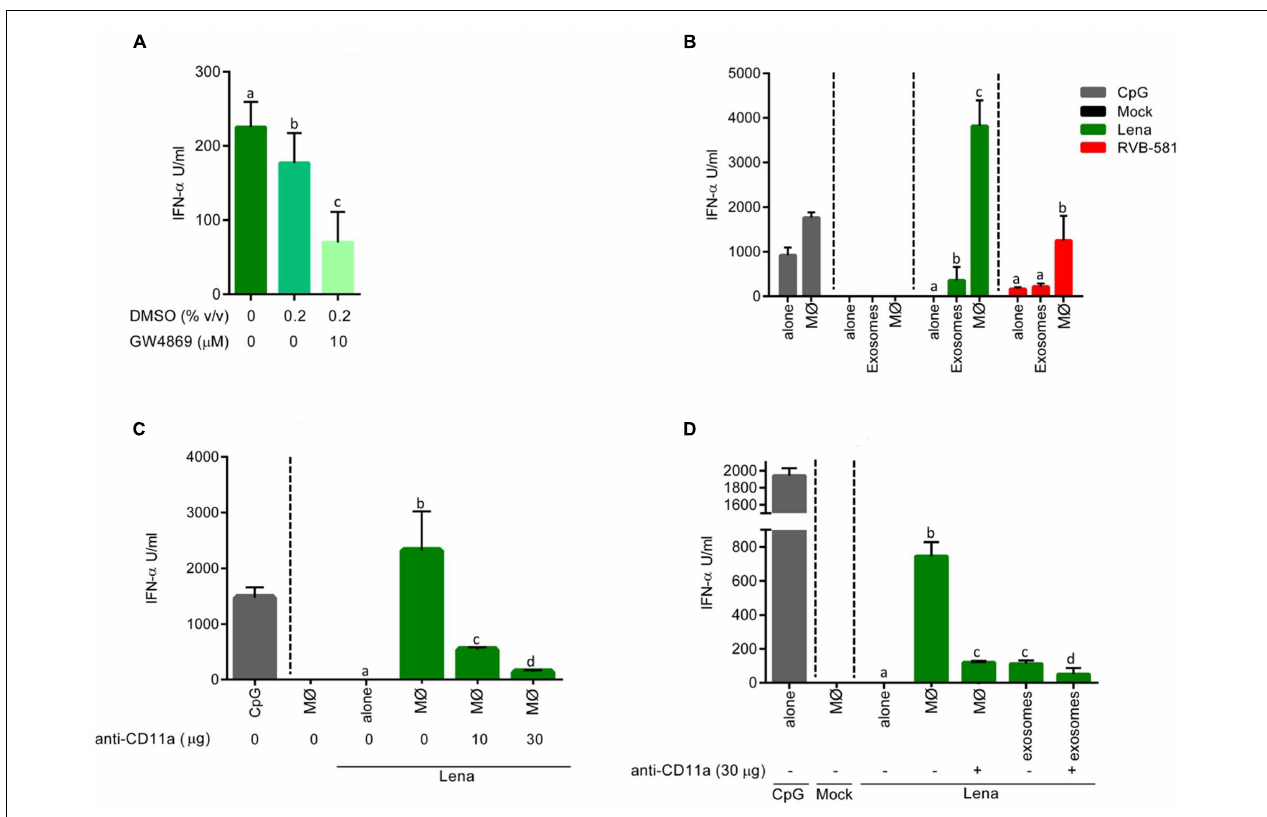
FIGURE 5 | pDC stimulation by PRRSV-infected MØ is dependent on integrin-mediated cell contact. (A) Stimulation of pDC by MØ-derived exosomes. MØ were infected with PRRSV Lena for 90 min followed by wash steps and addition of fresh medium. After 18 h of culture, exosome fractions were isolated and used to stimulate enriched pDC during 20 h at 39 ◦ C. The N-SMase inhibitor GW4869 was added at 10 µ M, DMSO alone was added at 0.2% (v/v) or the cells were left untreated. (B) Stimulation of pDC by infected MØ is superior to exosome stimulation. pDC were stimulated with PRRSV (Lena or RVB-581) virions at MOI 0.1 TCID 50 /ml (“alone”), with PRRSV-infected (Lena or RVB-581) MØ, with exosome fractions isolated from supernatant of PRRSV-infected (Lena or RVB-581) MØ; CpG D32 was included as control of pDC activation. (C) pDC stimulation by infected MØ involves ITGAL (CD11a). pDC were stimulated with mock-treated MØ, with Lena virions at MOI 0.1 TCID 50 /ml (“alone”) and with Lena-infected MØ. Anti-CD11a mAb was added to the co-cultures at 10 or 30 µ g/ml as indicated. CpG D32 was included as control for pDC activation. (D) Effect of anti-CD11a on pDC stimulation by infected MØ or exosomes. pDC were stimulated with mock-treated MØ, with Lena virions at MOI 0.1 TCID 50 /ml (“alone”), with Lena-infected MØ or with the exosome fraction isolated from Lena-infected MØ. Anti-CD11a mAb was added to the co-culture and to the exosome fraction stimulation at 30 µ g/ml. CpG D32 was included as control for pDC activation. Experiments were done in triplicates, and represent three (A,B) or two (C,D) different experiments. Different letters on top of the bars indicate significant difference based on the Mann–Whitney test ( P < 0.05), whereas bars sharing same letters indicate no significant